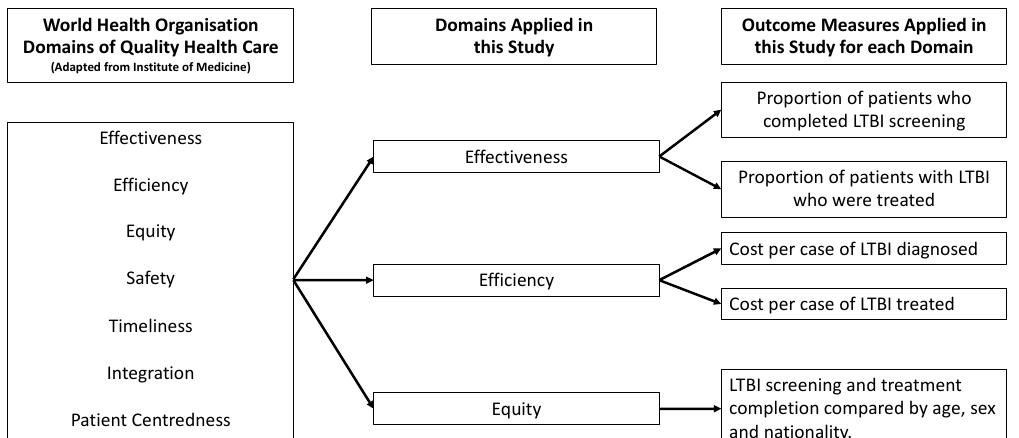
Figure 1. Framework, domains, and measures